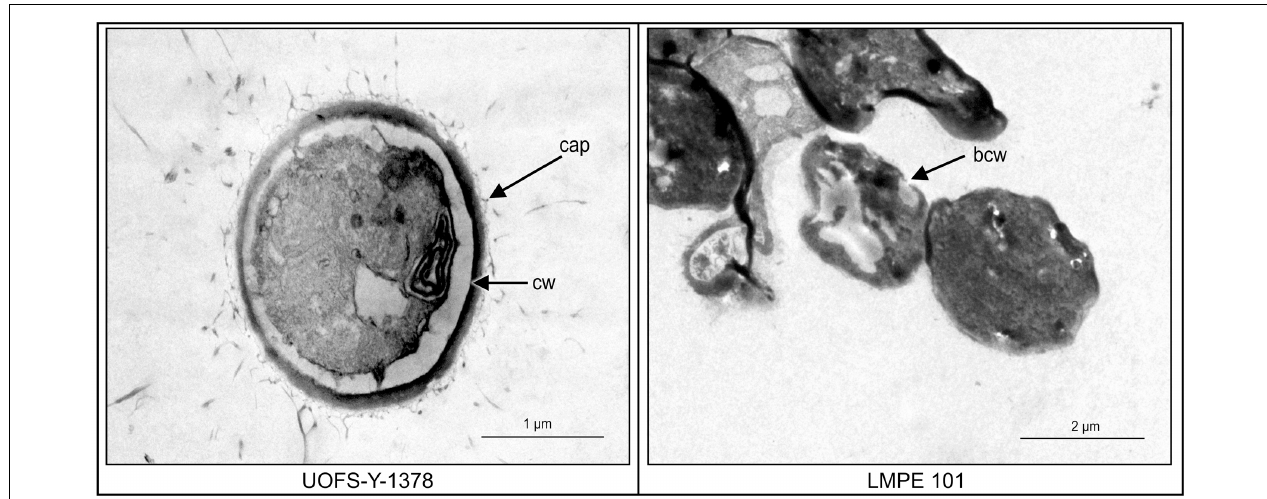
FIGURE 5 | A comparison of the effect of amoebapore on the ultrastructure of C. neoformans UOFS Y-1378 (has 3-hydroxy C9:0) and C. neoformans LMPE 101 (is acapsular and has no 3-hydroxy C9:0). When considering the strain 1378 results, it is conceivable that the expressed resistance may be due to the inability of amoebapore to create pores on its cell wall which is opposite to the results of the strain LMPE